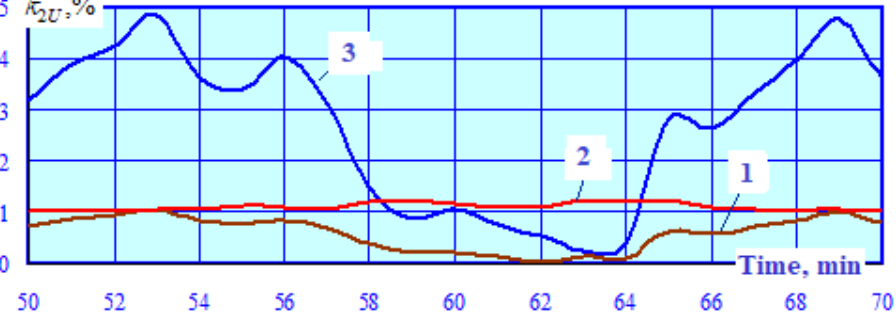
Figure 7. Negative sequence unbalance ratios at 220 kV buses of the TS—callout numbers correspond to those in Figure 6.